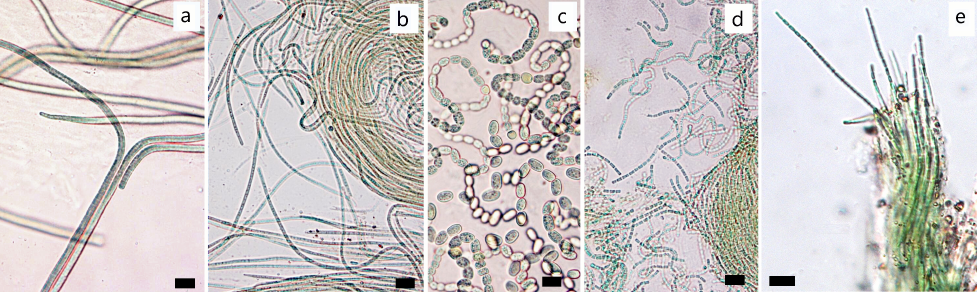
Figure 6. Some species of cyanobacteria identified in freshwater bodies: ( a )— Phormidium sp.; ( b )— Leptolyngbya sp.; ( c )— Nostoc sp.; ( d )— Pseudanabaena sp.; ( e )— Schizothrix sp. Scale bar is 10 μ m.